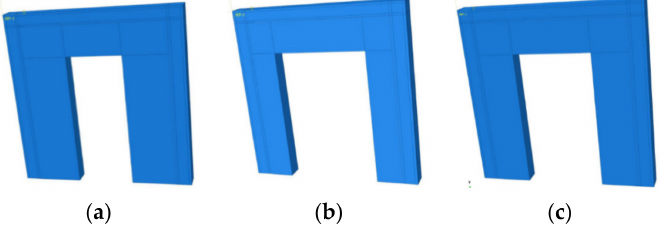
Figure 25. Wall models with different door holes’ dimensions: ( a ) wall ZWZ-7; ( b ) wall ZWZ-8; ( c ) wall